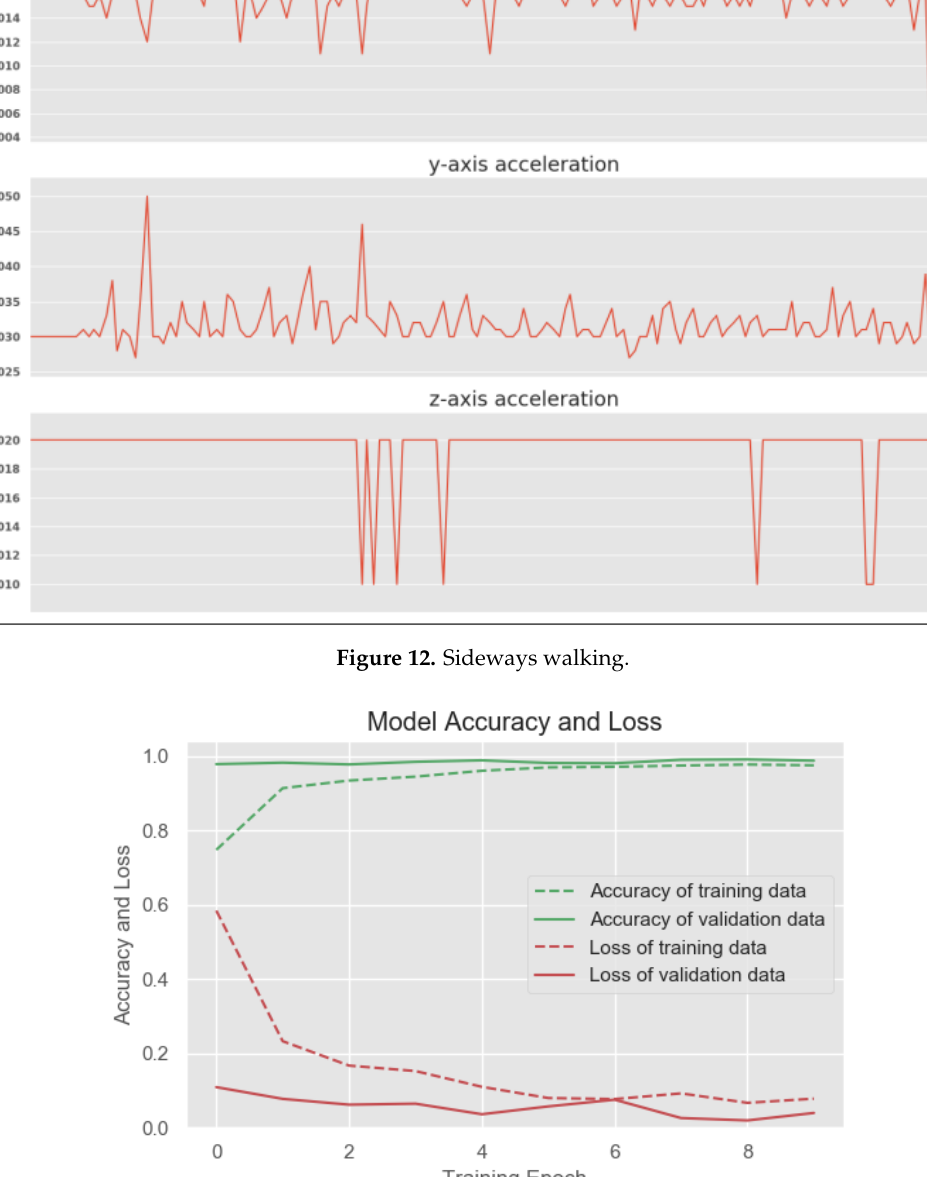
Figure 13. Model accuracy and